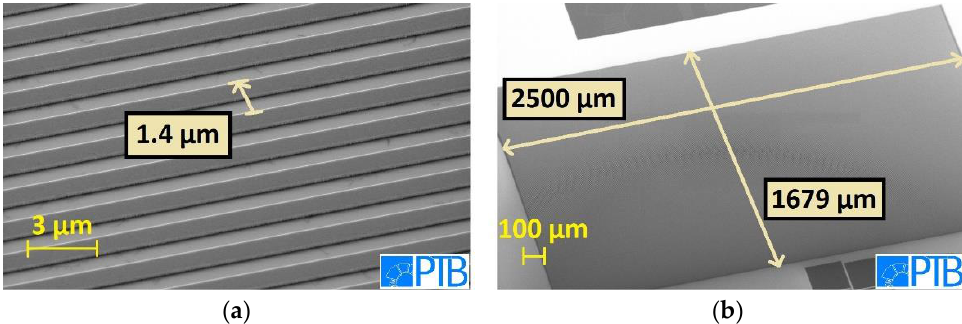
Figure 9. Scanning electron microscopy (SEM) images of a fine pitch interdigital capacitors (IDC) fabricated in the Nb base layer. ( a ) The IDC’s pitch = 1.4 µm equals the design value. ( b ) The large IDC shown here exhibits no visible defects.